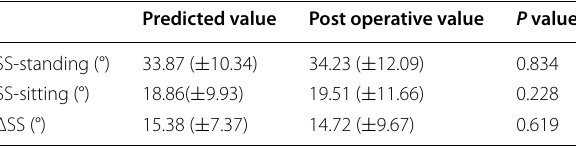
Table 5 The match rate within a targeted error range between the predicted and the measured